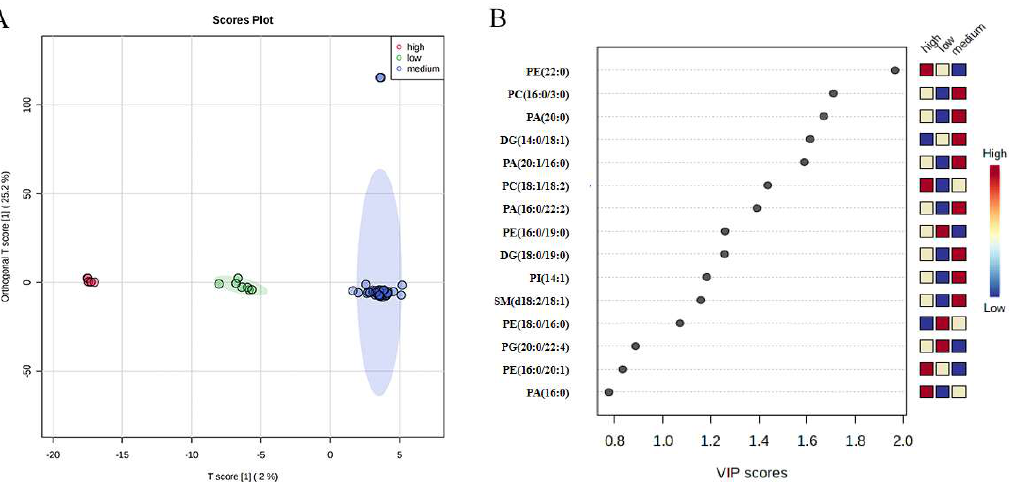
Figure 2. Significantly different lipids for indica rice. ( A ) OPLS-DA plot of lipid biomarkers for three grades of rice. ( B ) VIP scores for significantly different lipid species of OPLS-DA for three groups. Red and blue colors indicate high and low contents, respectively. 212